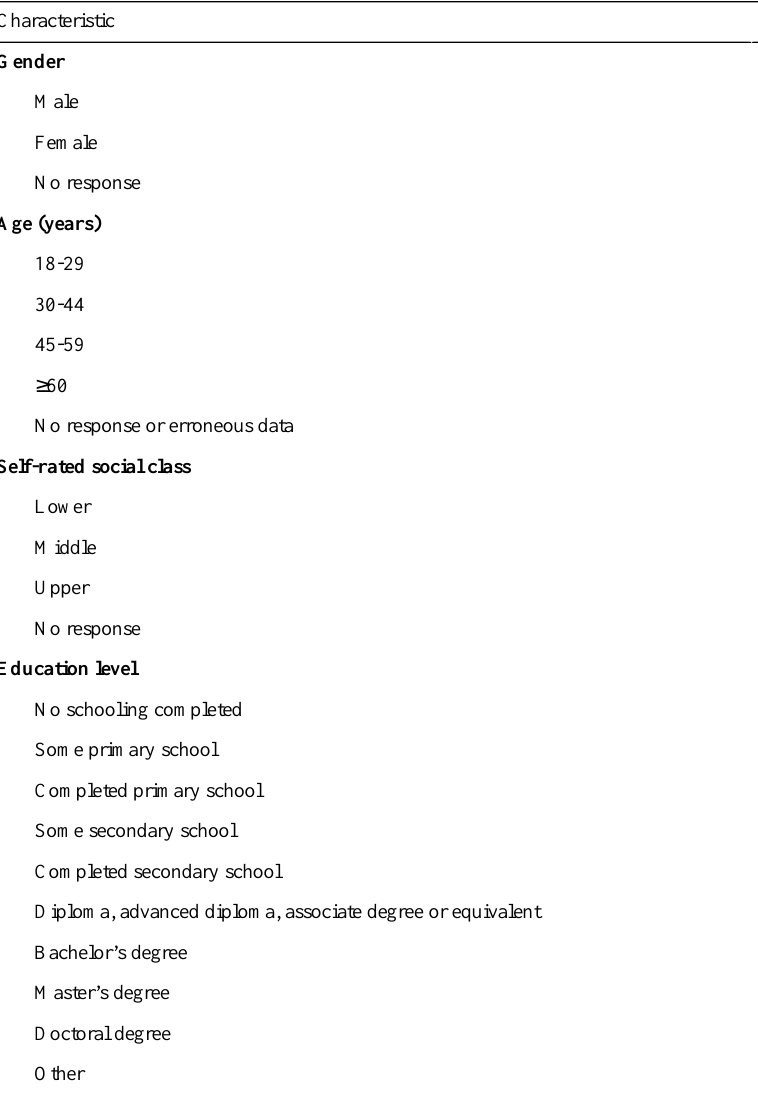
Table 1. Demographic characteristics of the sample